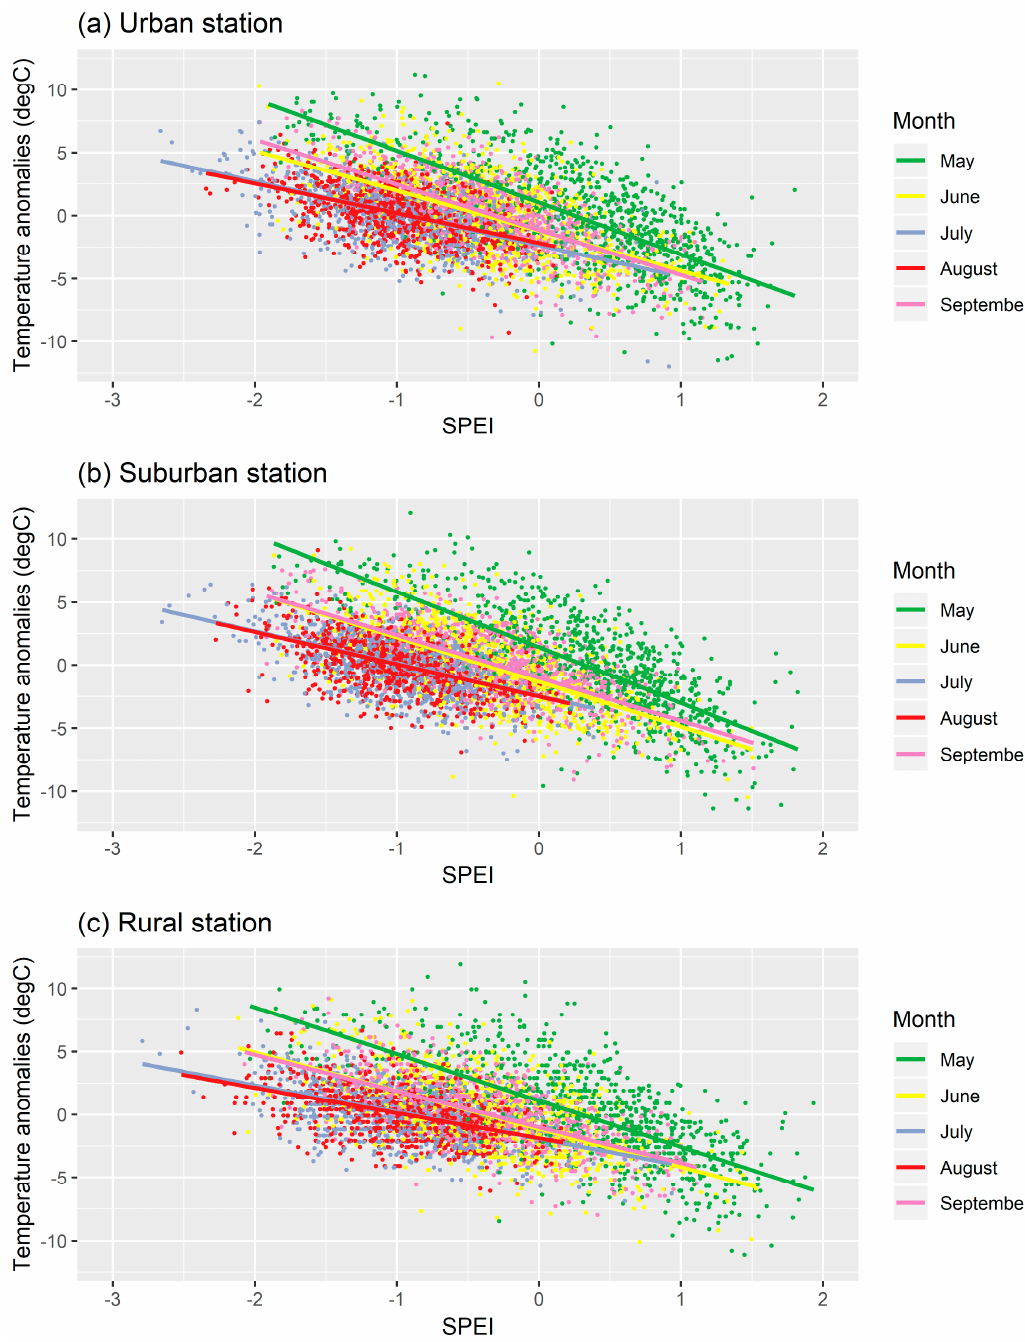
Figure 8. Regression lines for SPEI values and temperature anomalies (degC) for months May to September of years 1988–2017 for ( a ) urban station, ( b ) suburban station, and ( c ) rural